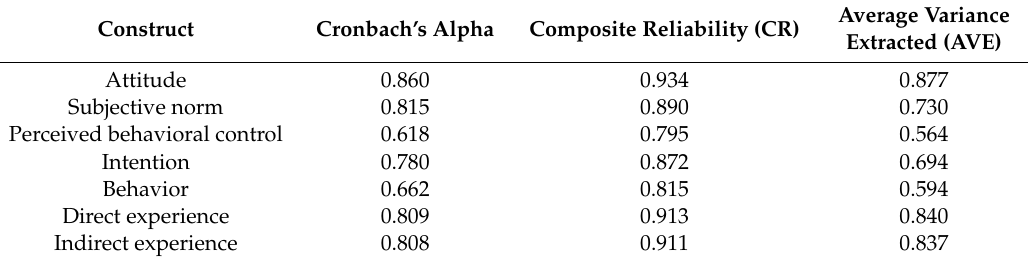
Table A3. Internal consistency: Cronbach’s alpha, composite reliability, and average variance extracted from the